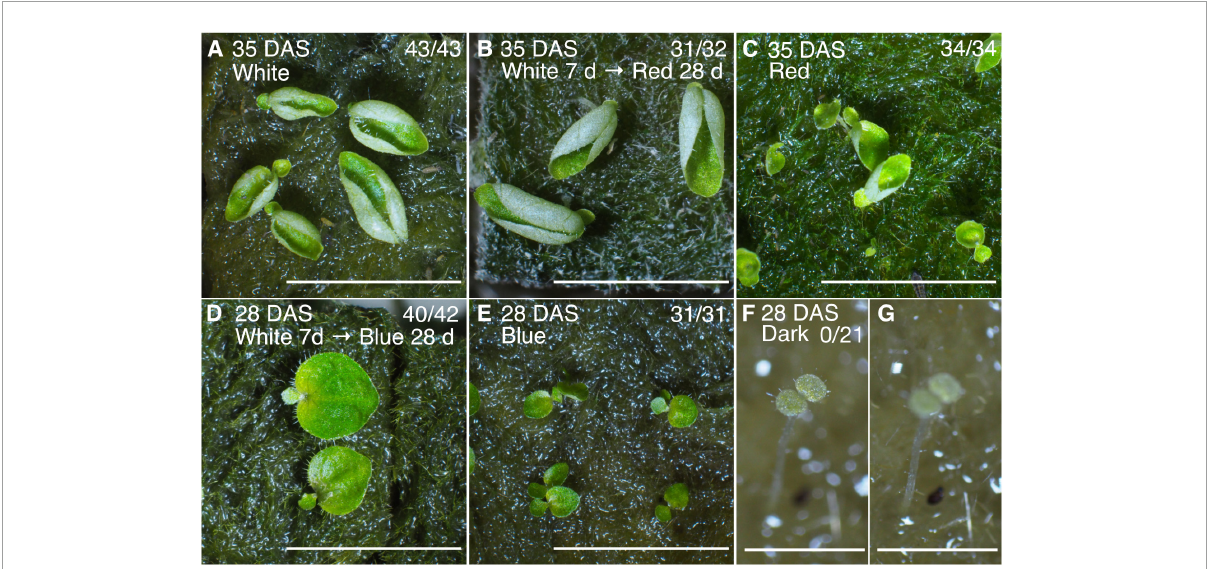
FIGURE6 Anisocotylous growth of M. glabra is observed both under red and blue light conditions. (A) Individuals at 35 DAS grown under white fluorescent light. (B) Individuals at 35 DAS grown under white fluorescent light for the first 7 days and red light for the subsequent 28 days. (C) Individuals at 28 DAS grown under red light. (D) Individuals at 35 DAS grown under white fluorescent light for the first 7 days and blue light for the subsequent 28 days. (E) Individuals at 28 DAS grown under blue light. (F,G) An individual at 28 DAS grown under dark conditions. The focus is on the cotyledons in (F) and on the petiolode in (G) . The denominator and numerator at the top right in each figure indicate the number of individuals germinated and the number of anisocotyl individuals, respectively. Bar = 1 cm in (A–E) and 1 mm in (F,G)